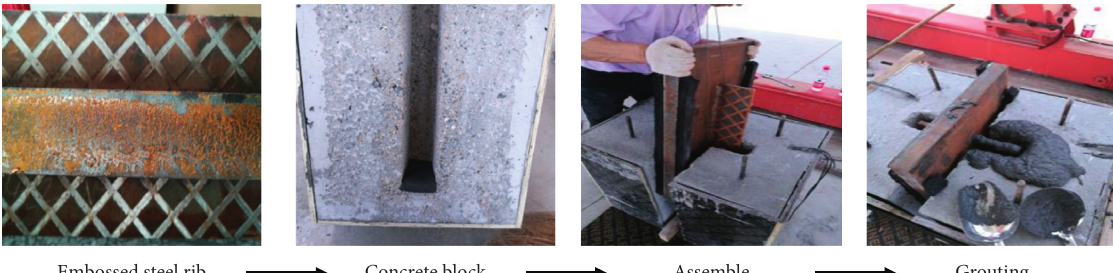
Figure 10: Fabrication of push-out test specimens.